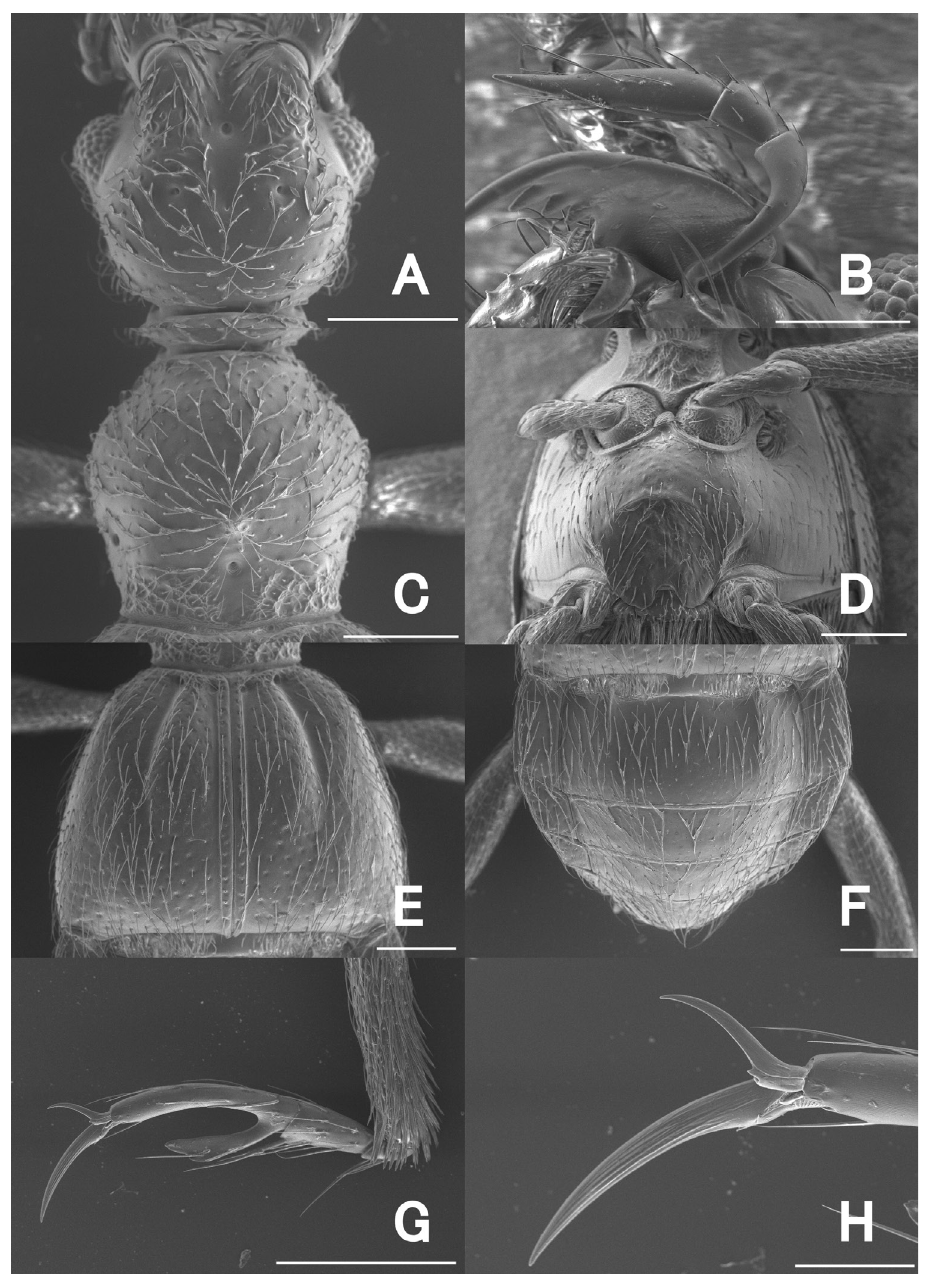
Figure 7. SEM images of Pseudophanias nakanoi , male A head B maxillary palp C pronotum D metaventrite E elytra F abdomen G mesotarsus H mesotarsal claws. Scale bar: 0.2 mm ( A, C–G ); 0.1 mm ( B ); 0.05 mm ( H